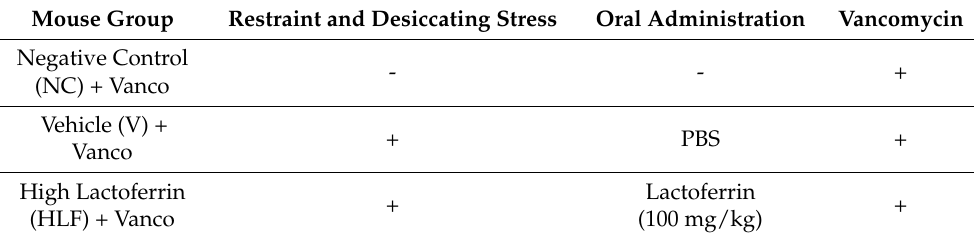
Table 2. Overview of the mouse groups in phenol red thread test with vancomycin. Mouse